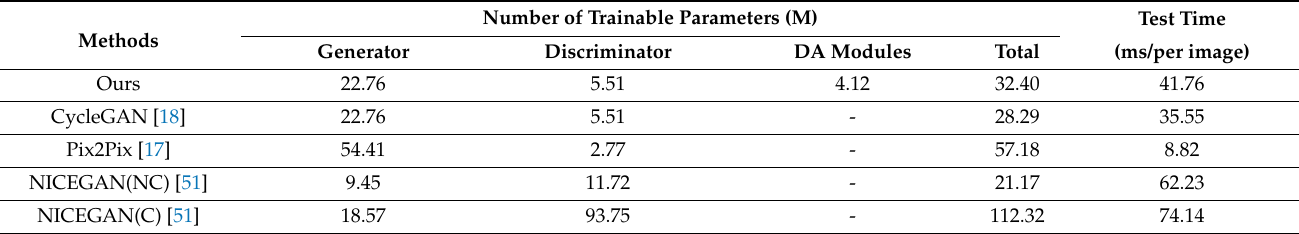
Table 6. Comparisons of model